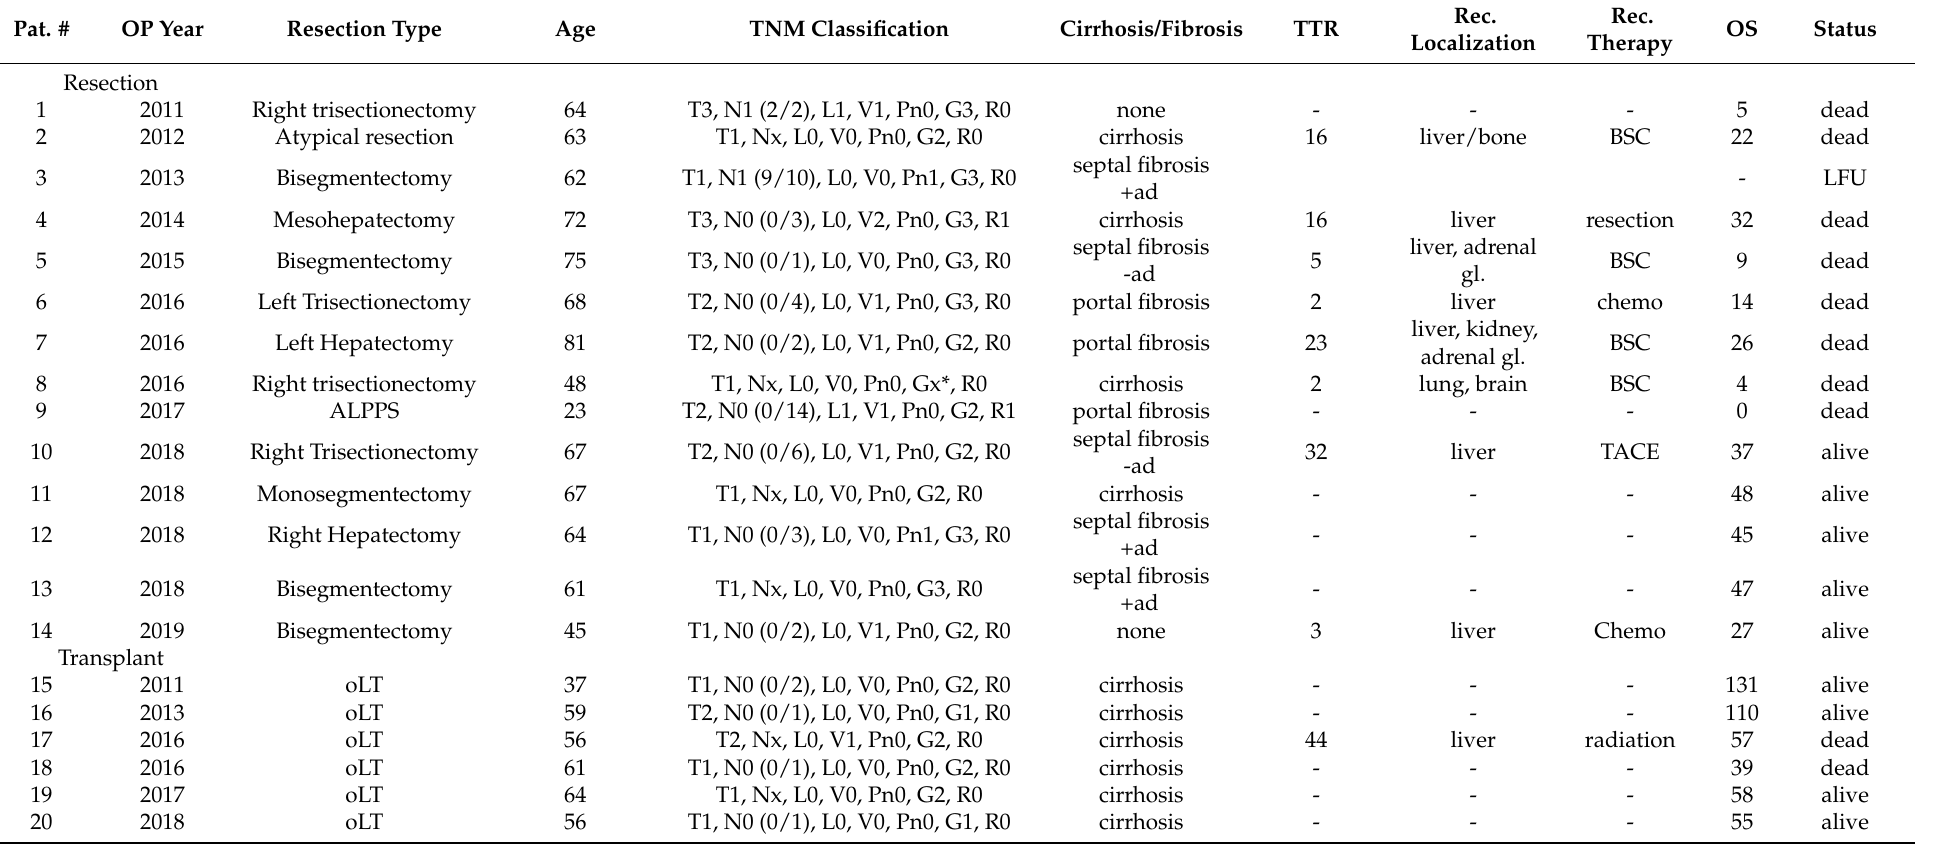
Table 4. mHC-CC patients with surgical procedures, histology, tumor recurrence, and